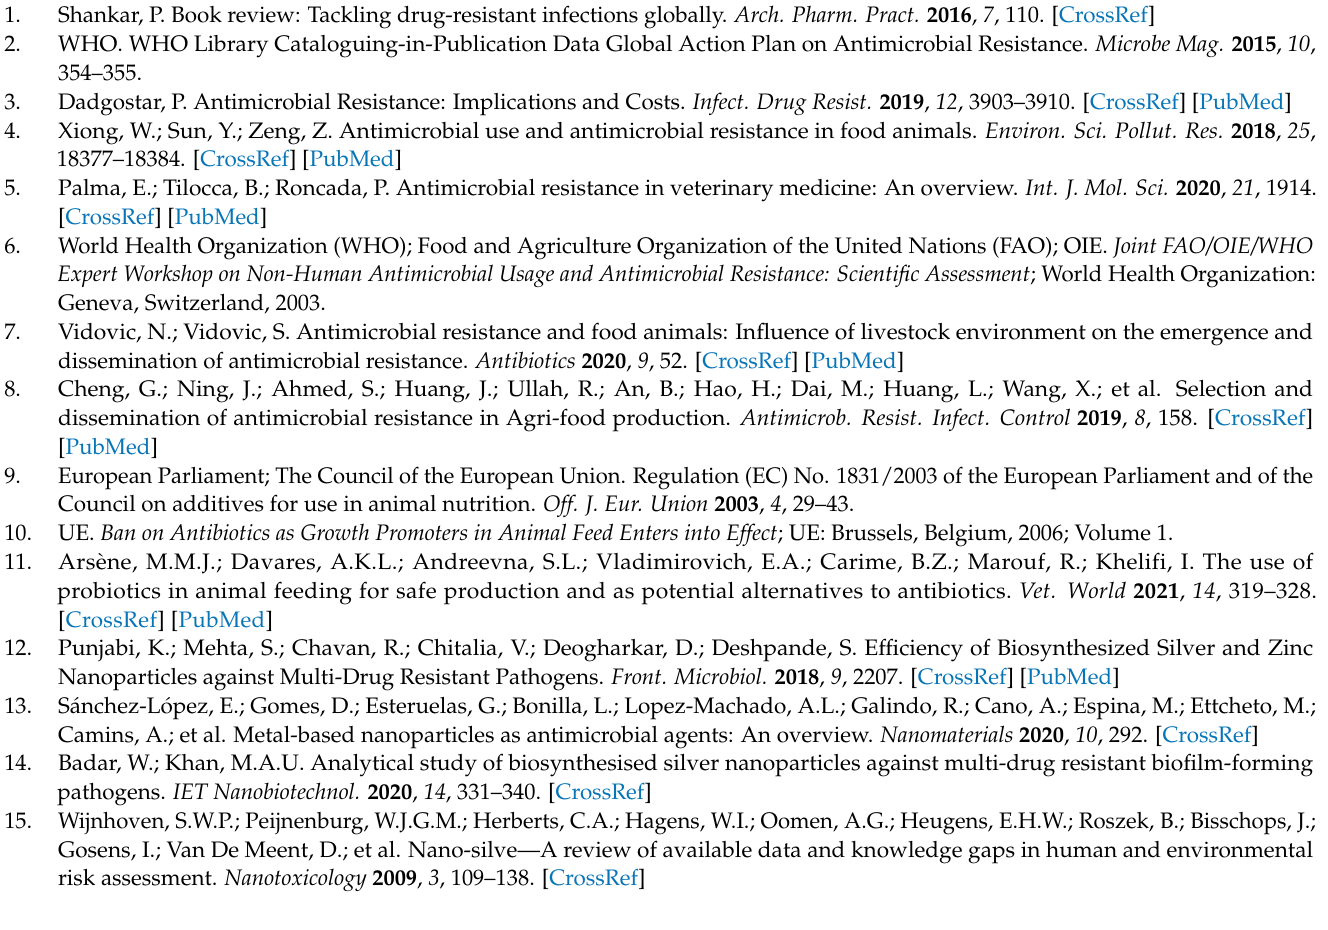
formulation. Figure S2: Weight size distribution of the silver-kaolin formulation. Figure S3: Mass distribution of silver internalized by L5178Y TK +/ − cells obtained by SC-ICP-MS analysis. Short treatment (10